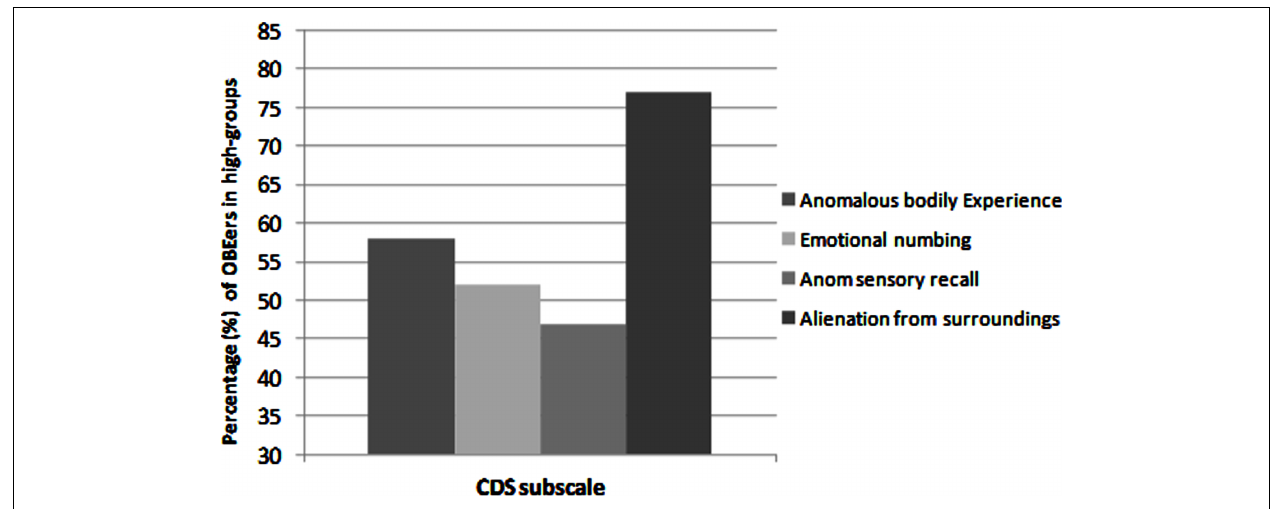
FIGURE 2 | Descriptive statistics (percentages) of those reporting OBEs in the high-groups of each subscale from the Cambridge Depersonalization Scale (CDS)